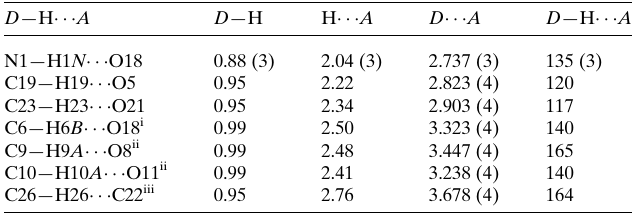
Table 1 Hydrogen-bond geometry (A˚ , (cid:3) ).